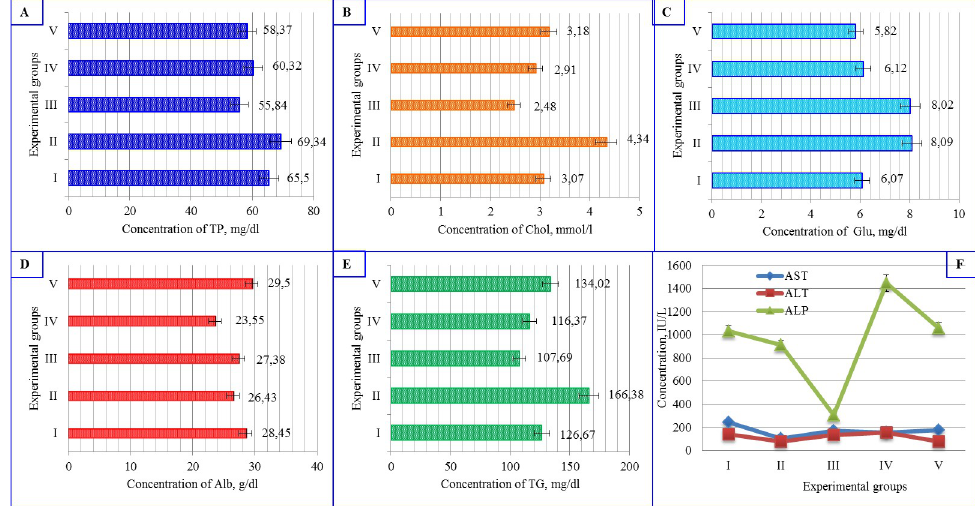
Fig 3. The results of assay of blood serum biochemical parameters after experiment. Groups: I = control, II = curd mass, III = curd mass mixed with flaxseed flour, IV = curd mass mixed with celery root powder, V = curd mass mixed with bee bread. (A) TP decreased in groups III, IV, V, but increased in group II compared to group I. (B) Chol level grew up in group II; in groups III and IV, it dropped; however, in group V slightly raised a group I results. (C) Glu raised in II and III, IV groups compare to I group; still, V group results show slightly decreasing; (D) Alb concentration decreased in group IV, yet in group V, it increased significantly than in group I results. Meanwhile, it changed groups II and III results with less percentage. (E) TG level dropped slightly in groups III and IV; however, in groups II, V it expanded. (F) AST levels in all blood plasma samples remained reduced by 30%-37% compared with the group I data. During the experiment, additives demonstrated a significant decrease in ALT in group III by 46% and increased in the IV and V groups up to 5% and 13%, respectively. Groups II, III, IV De Ritis ratio decreased to 25%-27%, and group IV increased to 44% compared to group I results. � Values are given as mean ± SD for a total of 50 animals. p < 0, 05 versus mice fed regular diet.